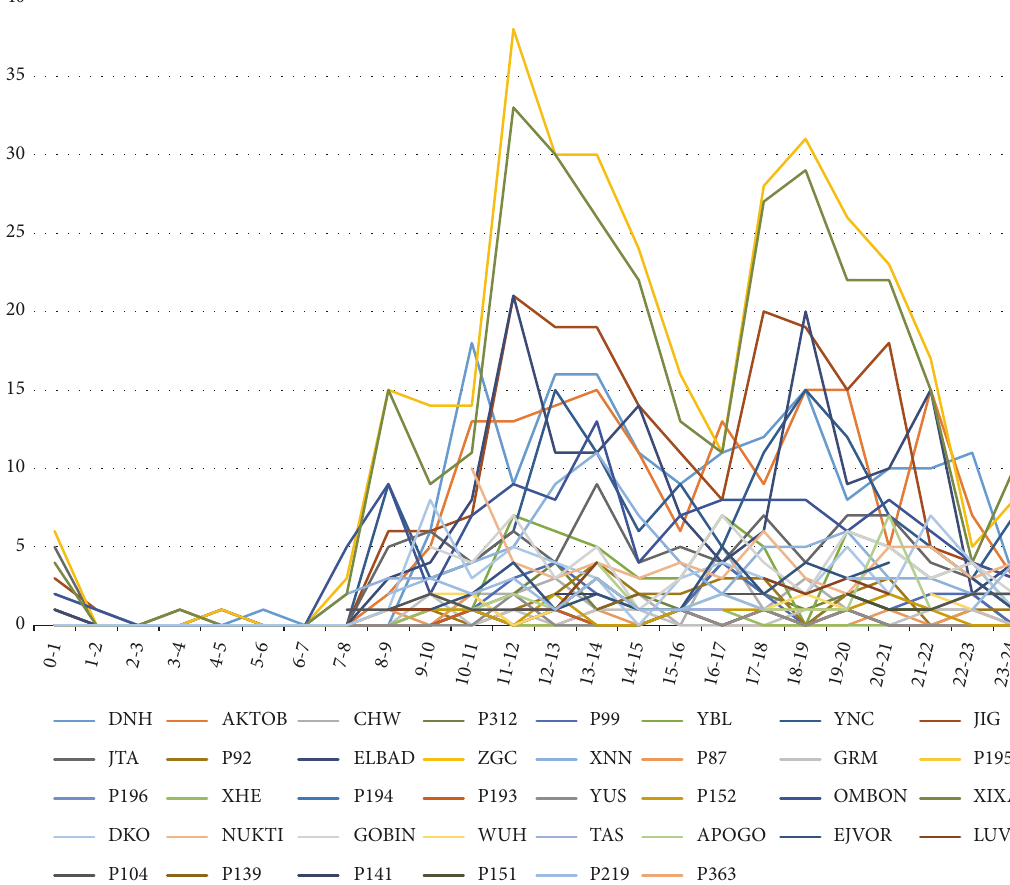
Figure 6 is a time distribution line chart of the flow of main airway points on Lanzhou control area obtained from historical radar data. It can be seen from the figure that the traffic peak hours of Lanzhou control area are mainly